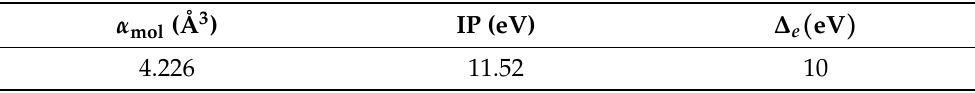
Table 1. Target properties of C 2 H 6 [49] ( α mol —molecular polarizability, IP—ionization potential, and ∆ e —first electronic excitation energy).